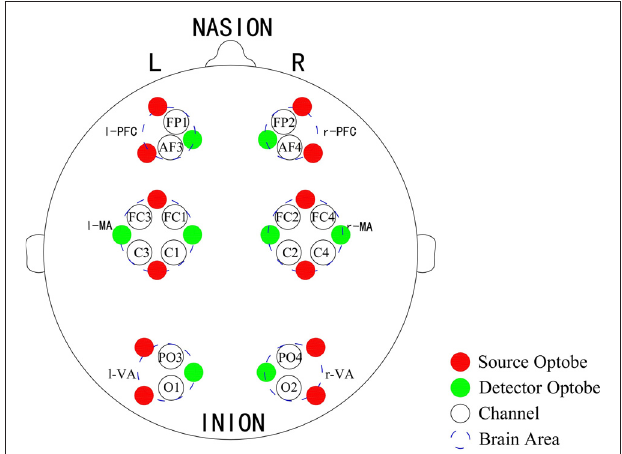
FIGURE 2 | Optode placement of 16 channels. Red dots denote the source optodes, green dots denote the detector optodes, and blue dashed circles represent the corresponding brain areas. The measurement channels (black circles) in the prefrontal cortex (PFC), motor-related areas (MA) and vision-related areas (VA) are in accordance with the international 10/10